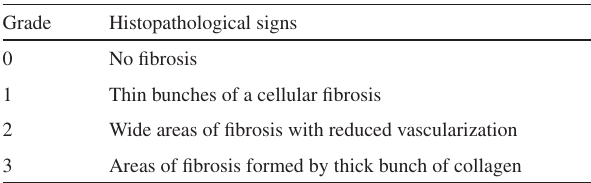
Grade Histopathological signs 0